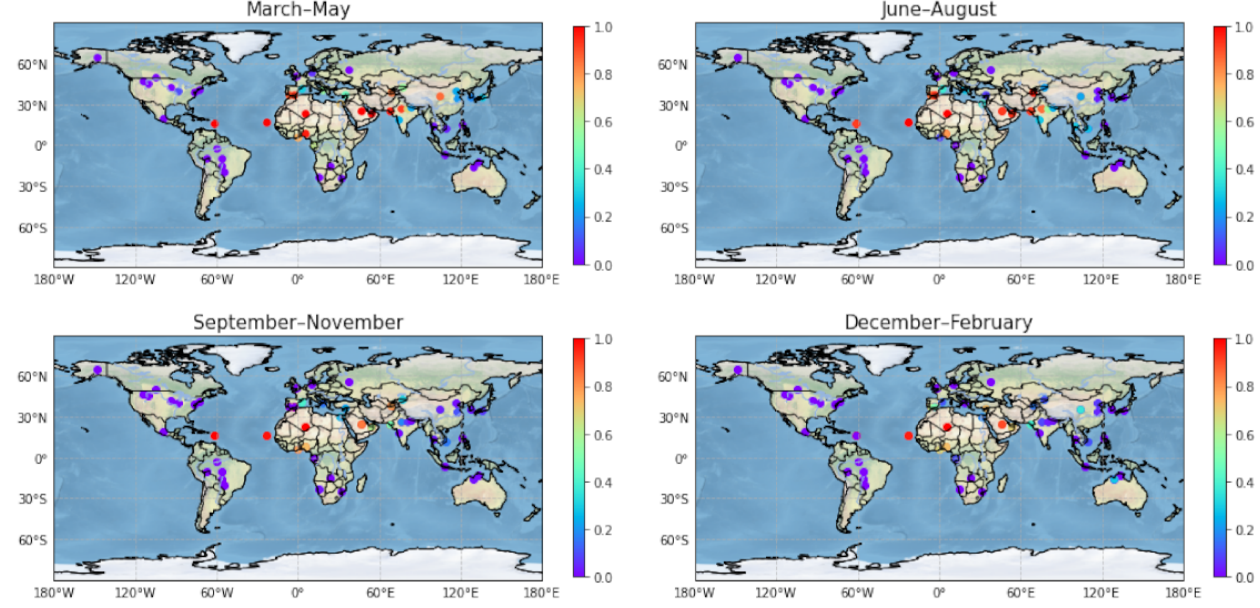
Figure 4. Temporal distribution of dust and dust dominated aerosols. The color dot in each station implies the values of occurrence frequency in the color